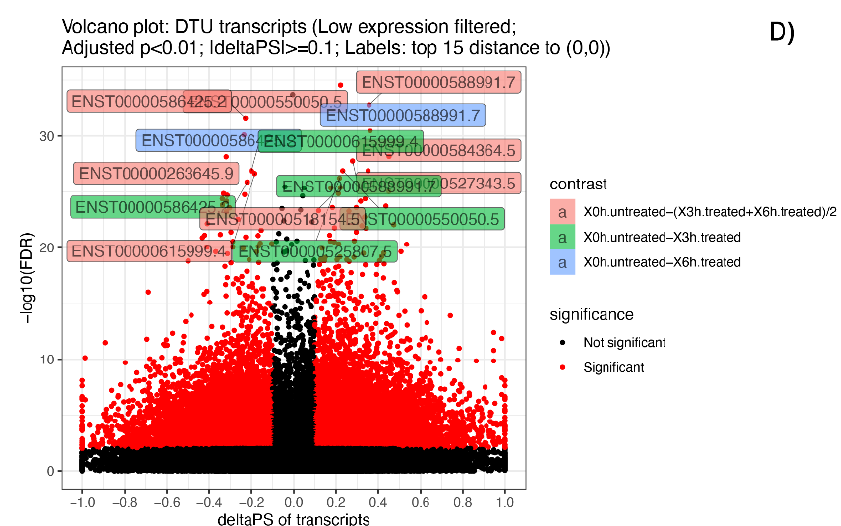
Figure 6. Volcano plots of significant DE and DAS genes and of DE and DTU transcripts. Volcano plots of significant (adjusted p -value < 0.01) DE genes ( A ), DE transcripts ( B ), DAS genes ( C ) and DTU transcripts ( D ). The low expressed genes and transcripts were filtered. The top 15 considered elements with the smallest corrected p -values and bigger fold-changes are highlighted, and di ff erent colors refer to di ff erent contrast groups. DE genes: log2FC vs. − log10(FDR) at gene level; DAS genes: maximum ∆ PS of transcript in a gene vs. − log10(FDR) at gene level; DE transcripts: log2FC vs. − log10(FDR) at gene level at transcript level and DTU transcripts: ∆ PS vs. − log10(FDR) at transcript